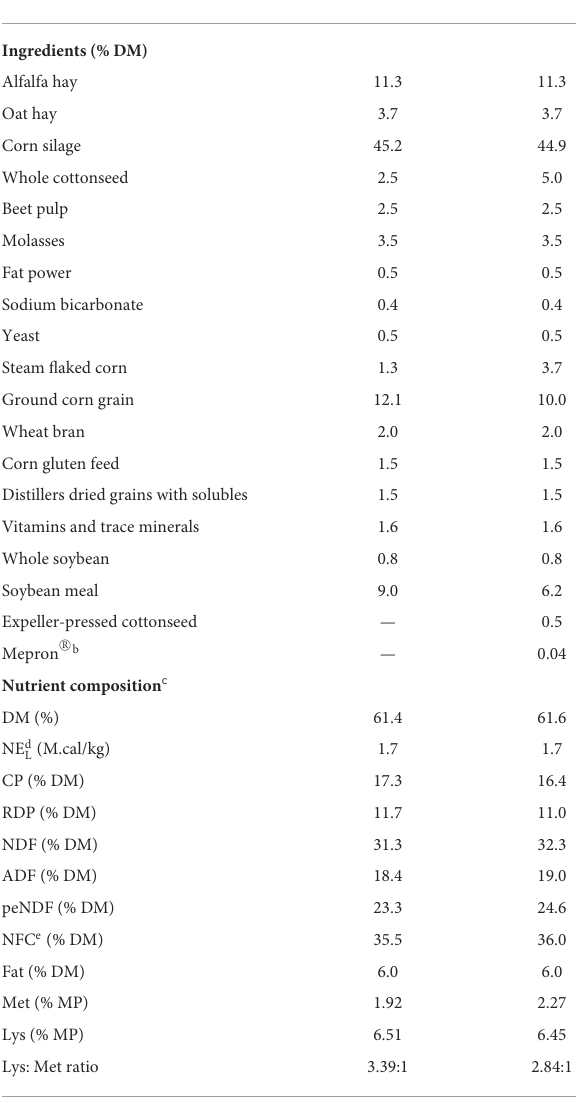
TABLE 1 Ingredients and nutrient composition in diets a